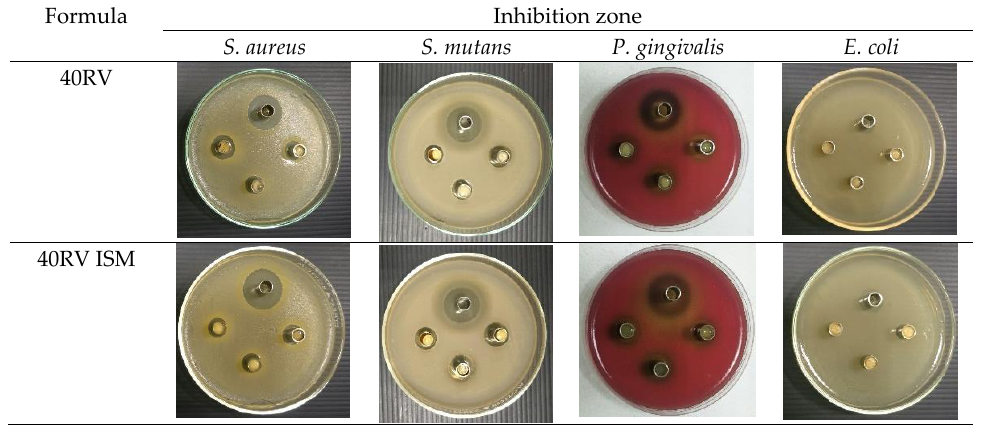
Figure 8. Photographs of the inhibition zone of 40RV and 40RV ISM formulations against S. aureus, S. mutans, P. gingivalis, and E. coli (n = 3) and the control group (VD) at upper side cup.